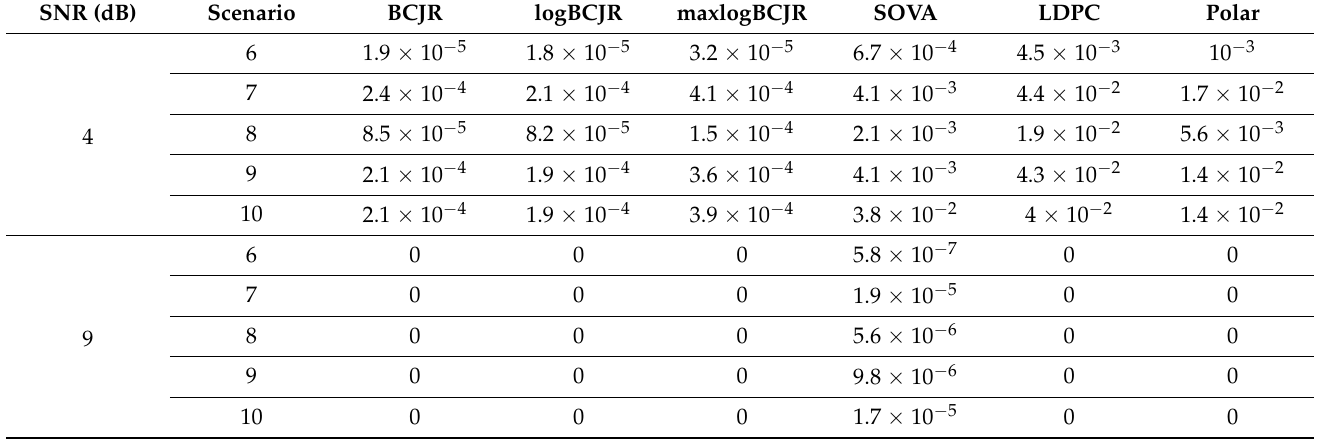
Table 10. BER values for 4 and 9 dB SNR, 256-bit